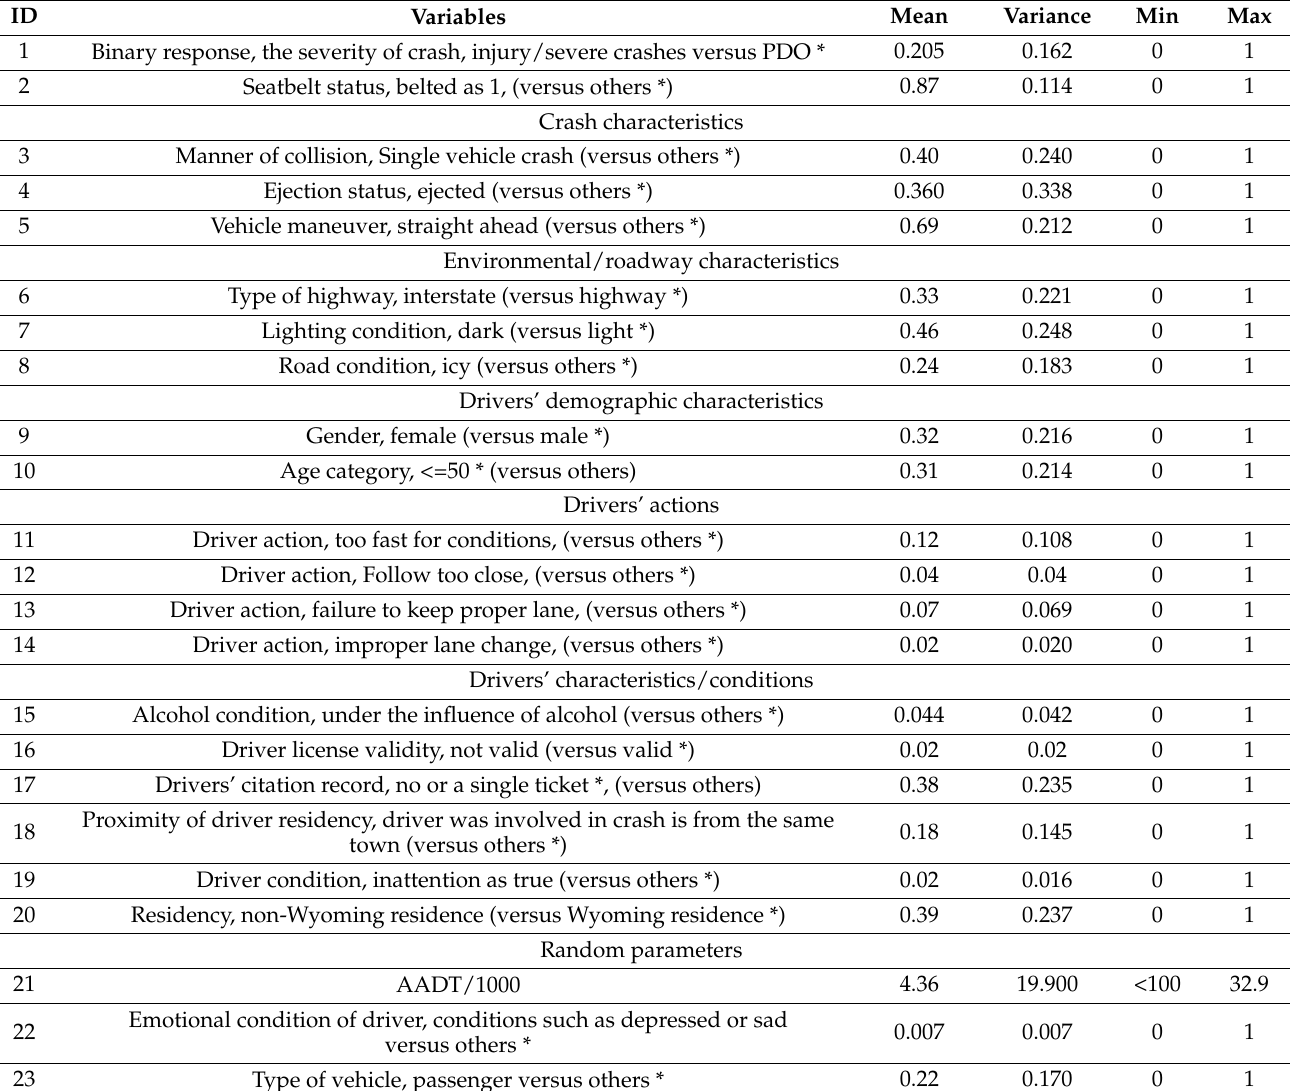
Table 1. Descriptive summary of important